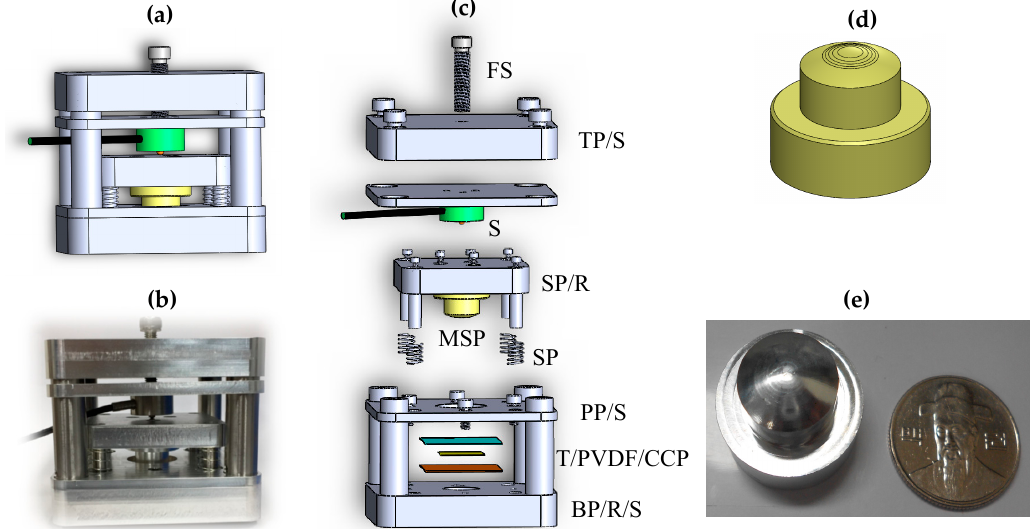
Figure 4. ( a ) Design of the press-fit system for creating the front face of the multi-focal point (MFP) transducer. ( b ) Photograph of the press-fit system. ( c ) Components of the press-fit system: Base plate/rod/screw (BP/R/S), Teflon/PVDF film/copper-clad polyimide (T/PVDF/CCP), pressure plate/screw (PP/S), spring (SP), multi-spherical pattern (MSP), slide plate/rod (SP/R), sensor of force (S), top plate/screw (TP/S), force screw (FS). ( d ) Design of multi-spherical pattern for creating transducer using five focal points. ( e ) Photograph of multi-spherical pattern.